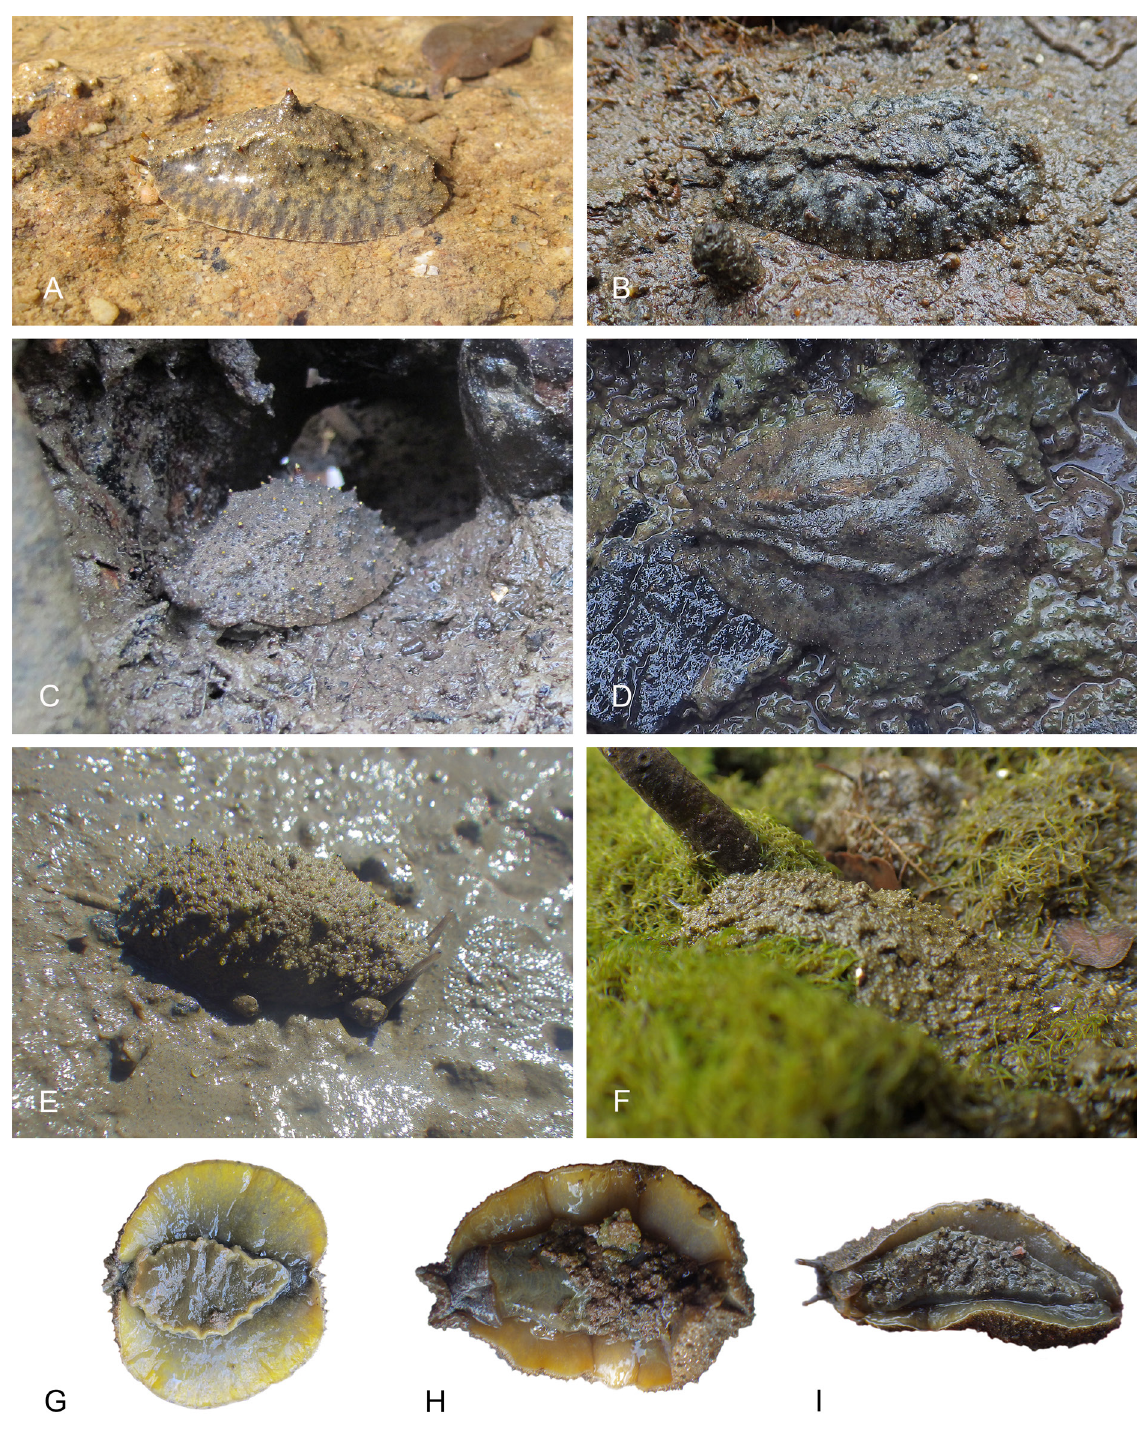
Fig. 9. Paromoionchis tumidus (Semper, 1880) comb. nov. unit #2, live animals. A . Dorsal view, 38 mm long [1651], Australia, Northern Territory (NTM P.57624). B . Dorsal view, 32 mm long [3237], Philippines, Luzon (PNM 041265). C . Dorsal view, 45 mm long [1638], Australia, Northern Territory (NTM P.57623). D . Dorsal view, 43 mm long [1794], Indonesia, Sumatra (UMIZ 00138). E . Dorsal view, 17 mm long [2960], Indonesia, Lombok (UMIZ 00139). F . Dorsal view, 27 mm long [3610], Philippines, Luzon (PNM 041261). G . Ventral view, same as C. H . Ventral view, same as D. I . Ventral view, 32 mm long [3229], Philippines, Luzon (PNM